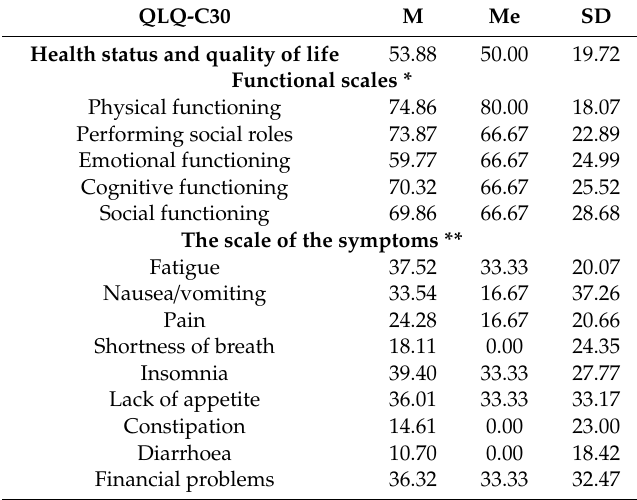
Table 2. Assessment of women’s quality of life—categories related to QLQ-C30.